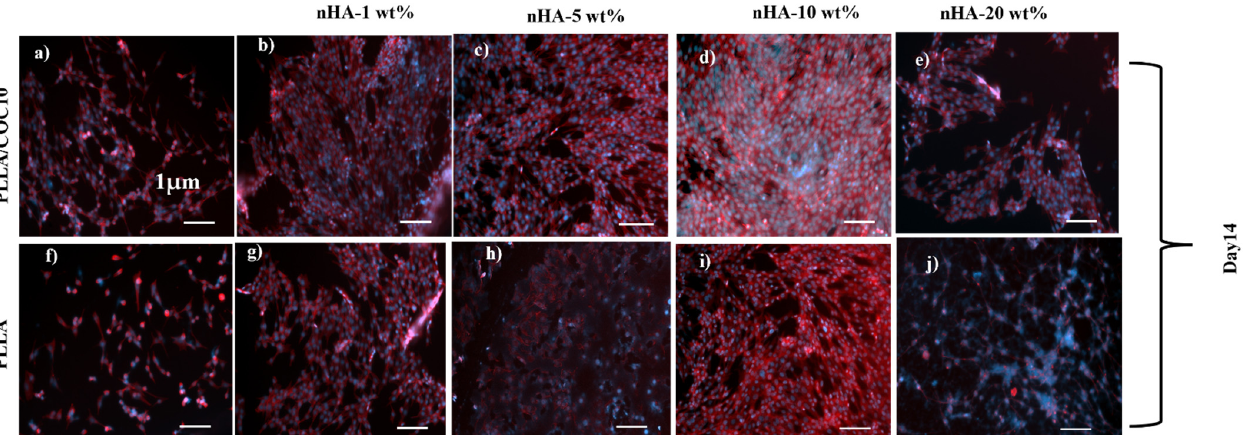
Figure 10. F-actin and DAPI staining in pre-osteoblast cells cultivated on PLLA/COC10-nHA and PLLA/nHA nanocomposites on week 2 (14 days ( a–j )) and week 3 (21 days ( a–j )). The scale bar is 1 μ m in diameter in all the images. Nanocomposites had nHA in 1 wt%, 5 wt%, 10 wt%, and 20 wt%. The color of F-actin was red, while the fluorescence of DAPI-labeled nuclei was blue. The DAPI staining revealed the morphology of the nuclei. A large number of pre-osteoblast cell nuclei suggested that the PLLA/COC10-nHA were cytocompatible with the cell line. The presence of actin filaments in cells indicates that they were alive. Actin filaments revealed a complex cytoskeleton with well-defined direction and connectivity in cells.